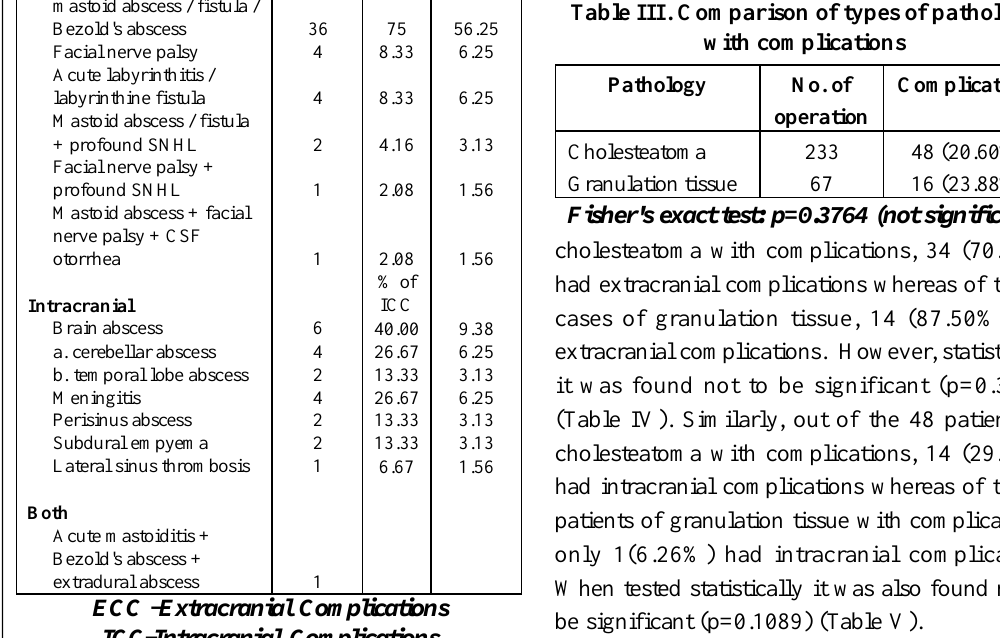
ECC -Extracranial Complications